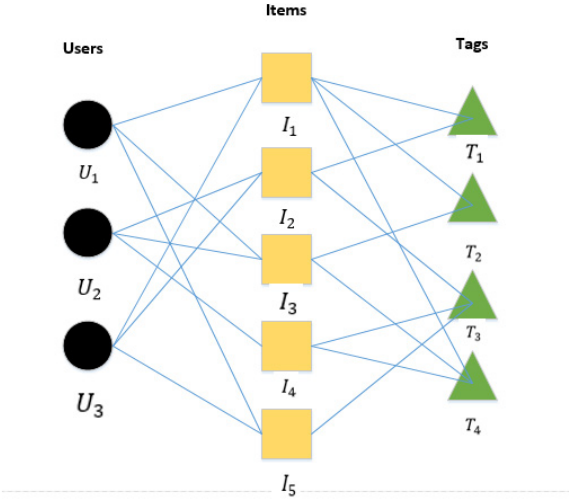
Fig. 1. A tripartite graph consists of three users, five items and four